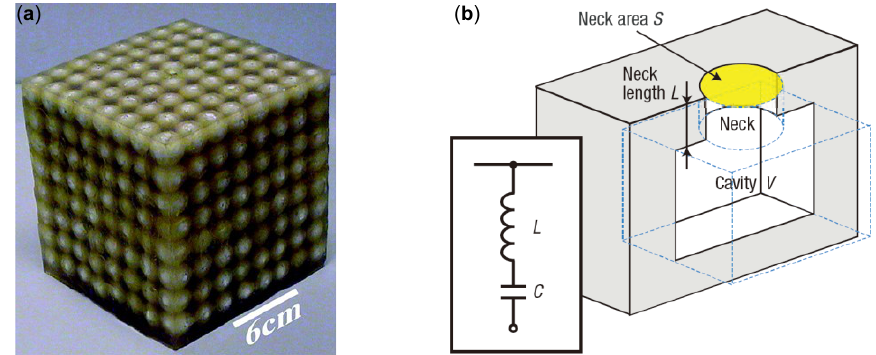
Figure 1. ( a ) Photograph of a local resonant acoustic structure. Adapted with permission from [82], The American Association for the Advancement of Science, 2000. ( b ) Schematic of periodical daisy-chained Helmholtz resonators. Adapted with permission from [83], Springer Nature, 2006.